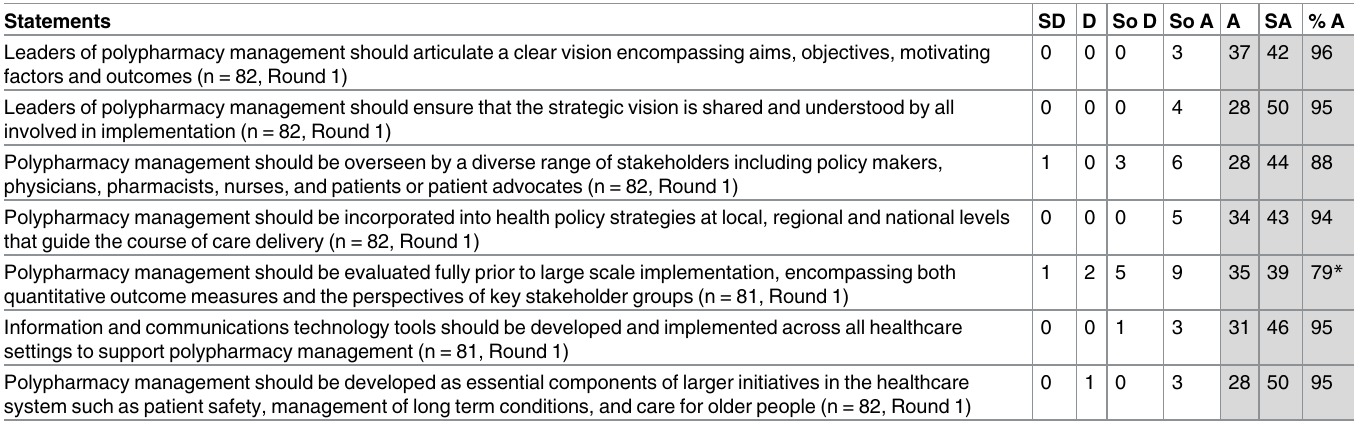
Table 4. Number of responses and % agreement(strongly agree/agree) to statements relating to strategic development.